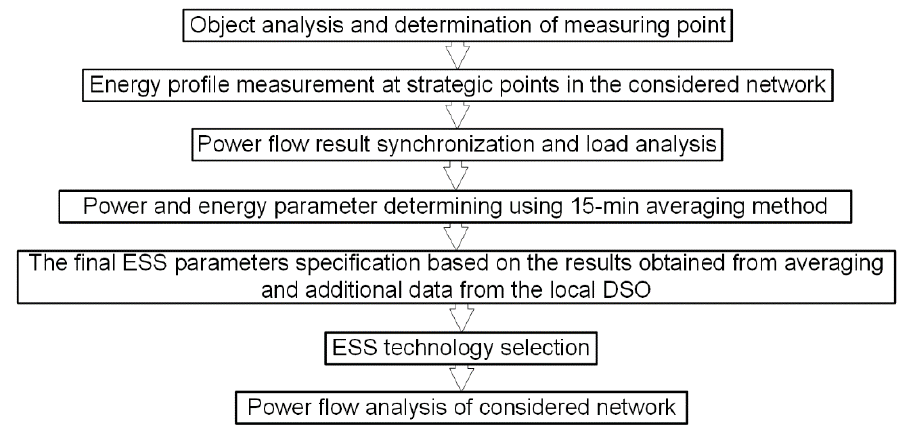
The object analysis allows the determination of appropriate measurement